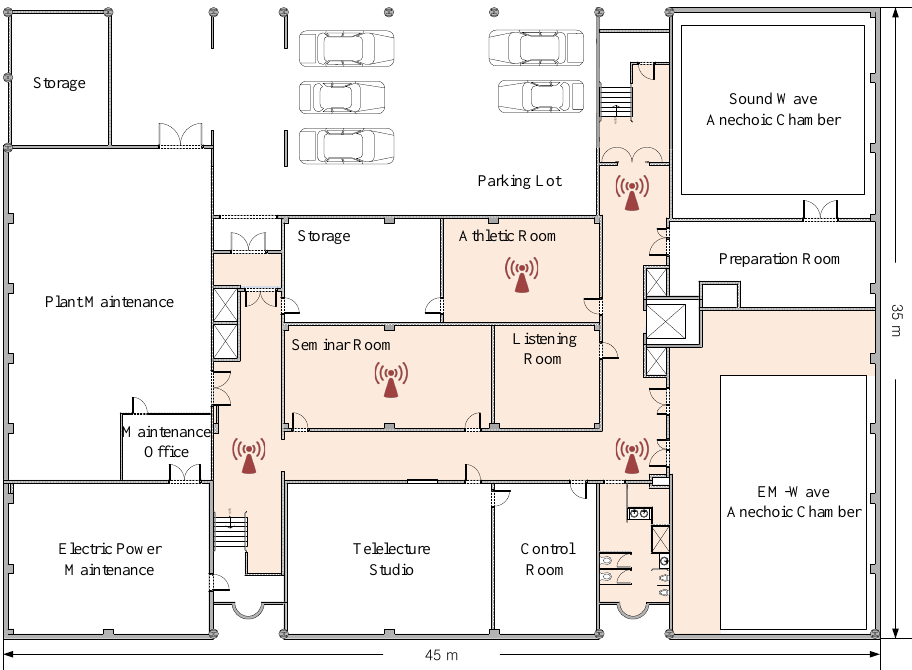
Figure 1. The experiment setup.